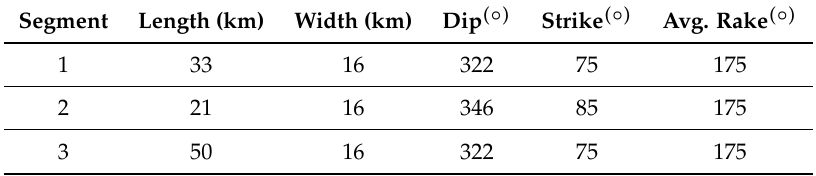
Table 1. Source parameters for the [49,50], the 1999 M w 7.1 Hector